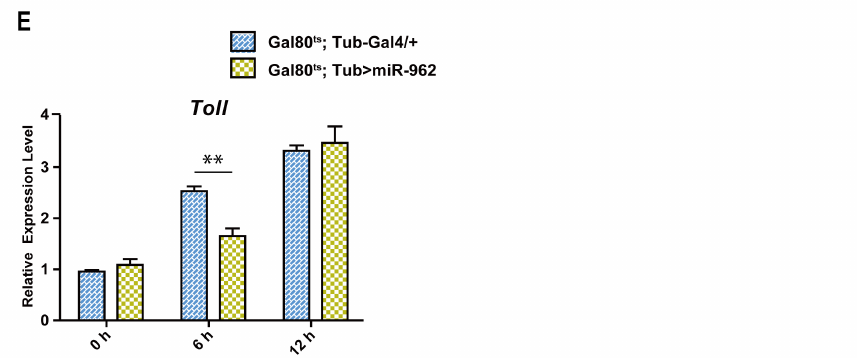
Figure 6. Four miRNA members from miR-959–962 cluster inhibit the expression of its target genes in vivo. The expression levels of tube were respectively tested in miR-959 high-expressing ( A ) and miR-960 high-expressing flies ( B ). ( C , D ) The expression levels of dl in miR-961 high-expressing and miR-962 high-expressing flies were respectively tested. ( E ) The expression level of Toll in miR-962 high-expressing flies was detected. (* p < 0.05; ** p < 0.01; *** p <